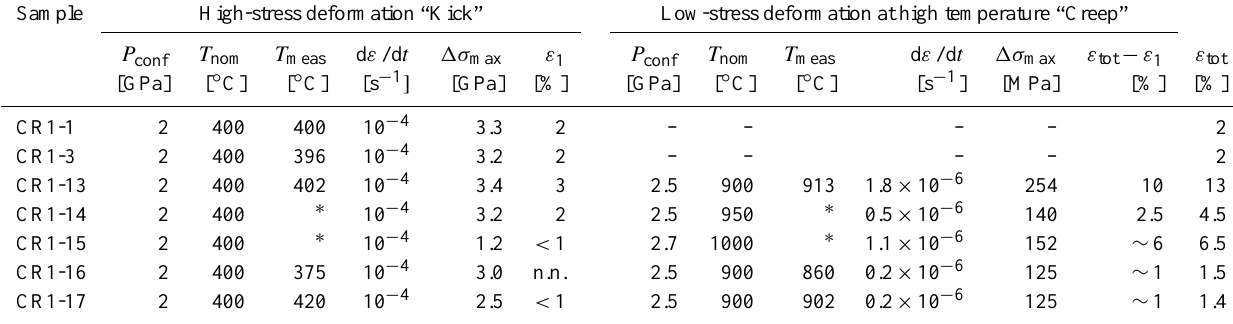
Table 1. Experimental data. Sample High-stress deformation